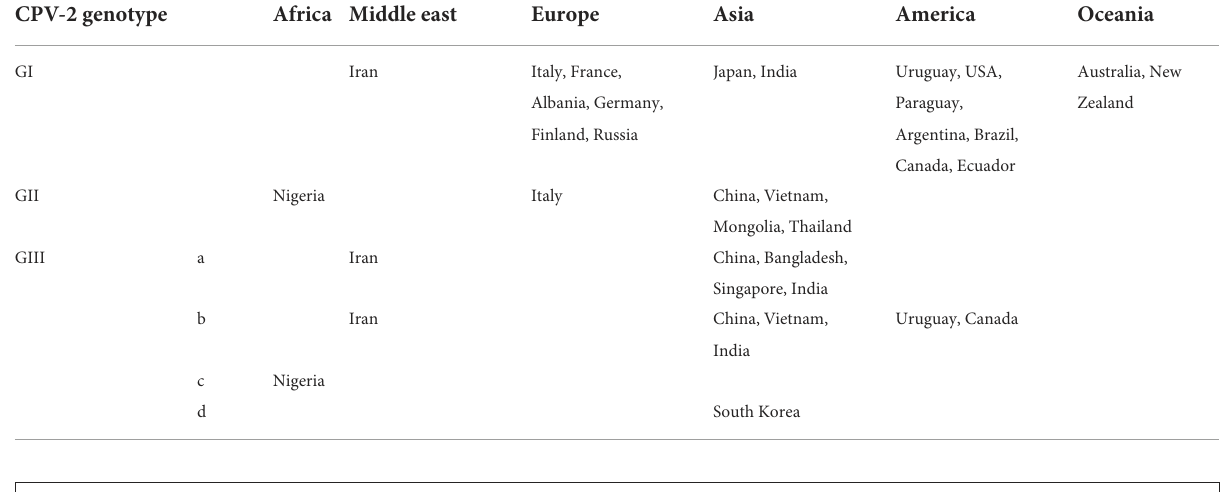
TABLE 2 Geographic distribution of CPV-2 genotypes.